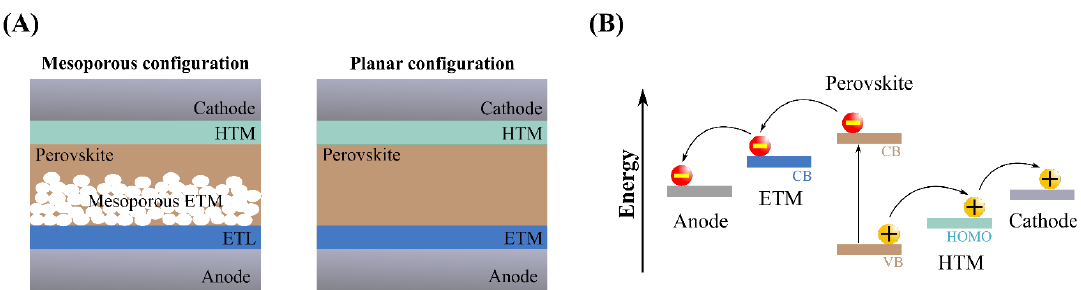
Figure 10. ( A ) Mesoporous and planar configurations of PSCs. ( B ) The energy diagram and charge transport in PSCs [102].